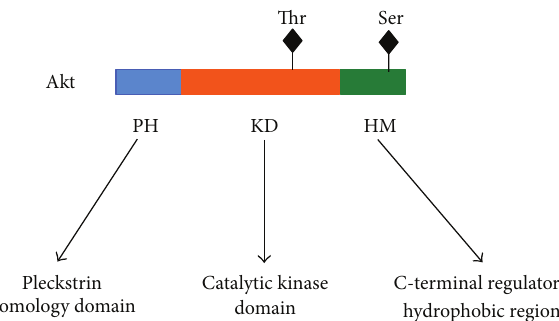
Figure 1: This figure illustrates the basic structure that is common among the three Akt isoforms (Akt1, Akt2, and Akt3). Each Akt isoform has three subdivisions: the Pleckstrin homology domain (PH), the catalytic kinase domain, and the C-terminal regulatory hydrophobic region (HM). In addition, the Akt activating threonine (Thr) and serine (Ser) residues are indicated in the figure. The coordinates of these two amino acid residues vary slightly among the three Akt isoforms and are listed in Table 1. The phosphorylation of these threonine and serine residues induces the activation of the Akt signaling system.